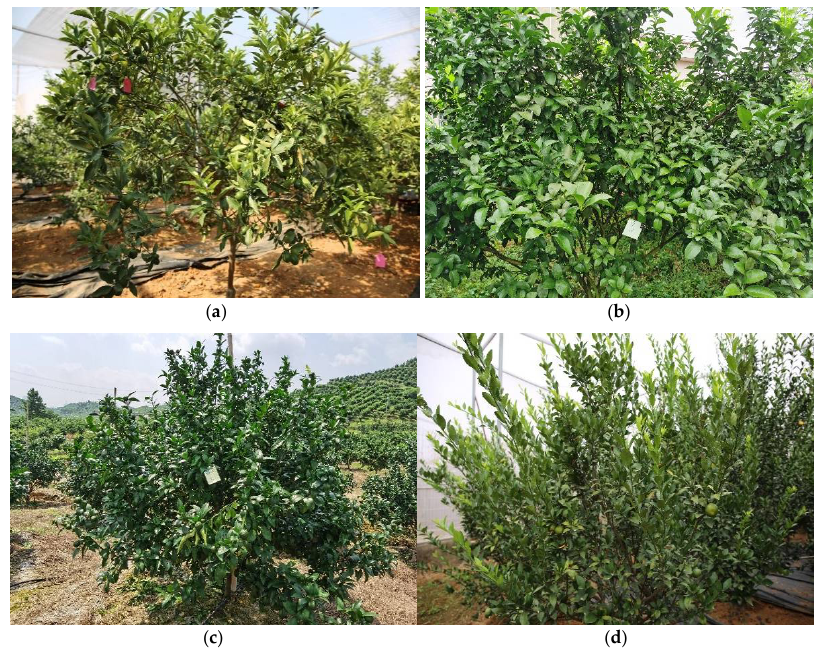
Figure 1. The RGB images of the four varieties of citrus: ( a ) Kumquat; ( b ) Shatang tangerine; ( c ) Fertile orange; ( d ) Nanfeng tangerine.